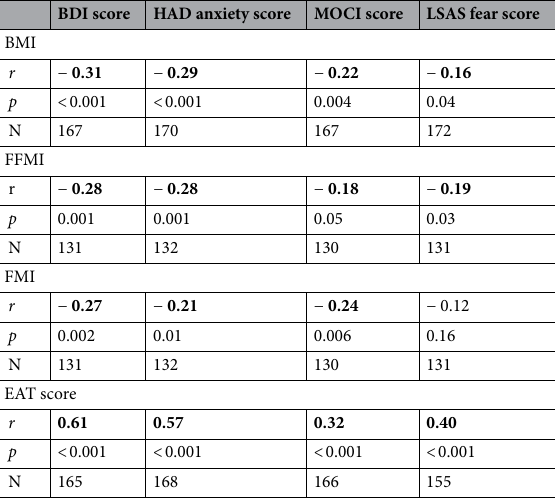
Table 3. Cross-sectional analyses: correlations between nutritional status indicators and psychopathological scores at discharge. Bold: Significant associations. BDI Beck’s Depression Inventory, HAD Hospital Anxiety and Depression scale, MOCI Maudsley Obsessive–Compulsive Inventory, LSAS Liebowitz Social Anxiety Scale, BMI Body Mass Index, EAT Eating Attitude Test, FFMI fat-free mass index, FMI fat mass